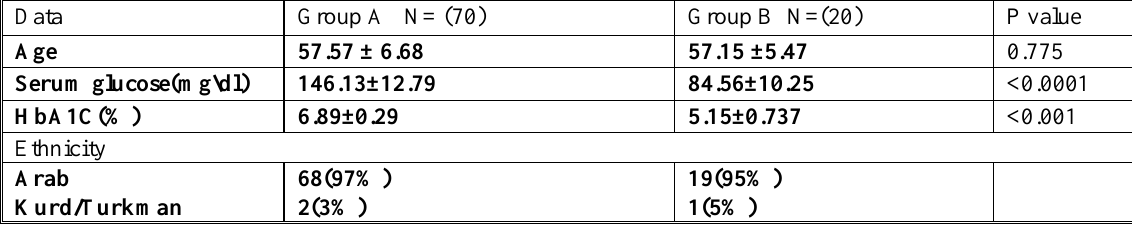
P value < 0.05 considered significant and P value < 0.01 considered high significant Genotypes and alleles frequency of